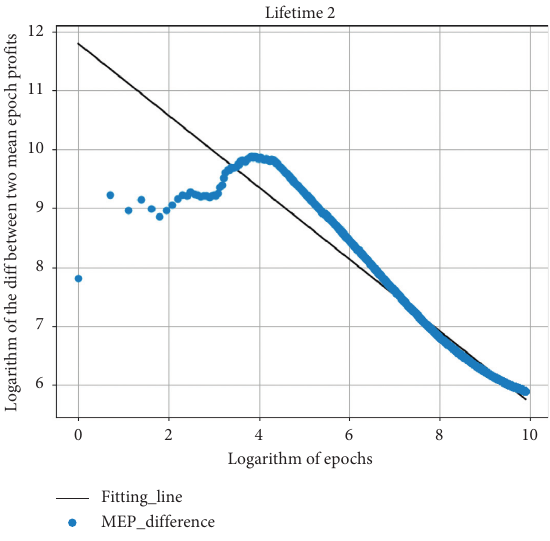
Figure 2: Log-log scale MEP difference.